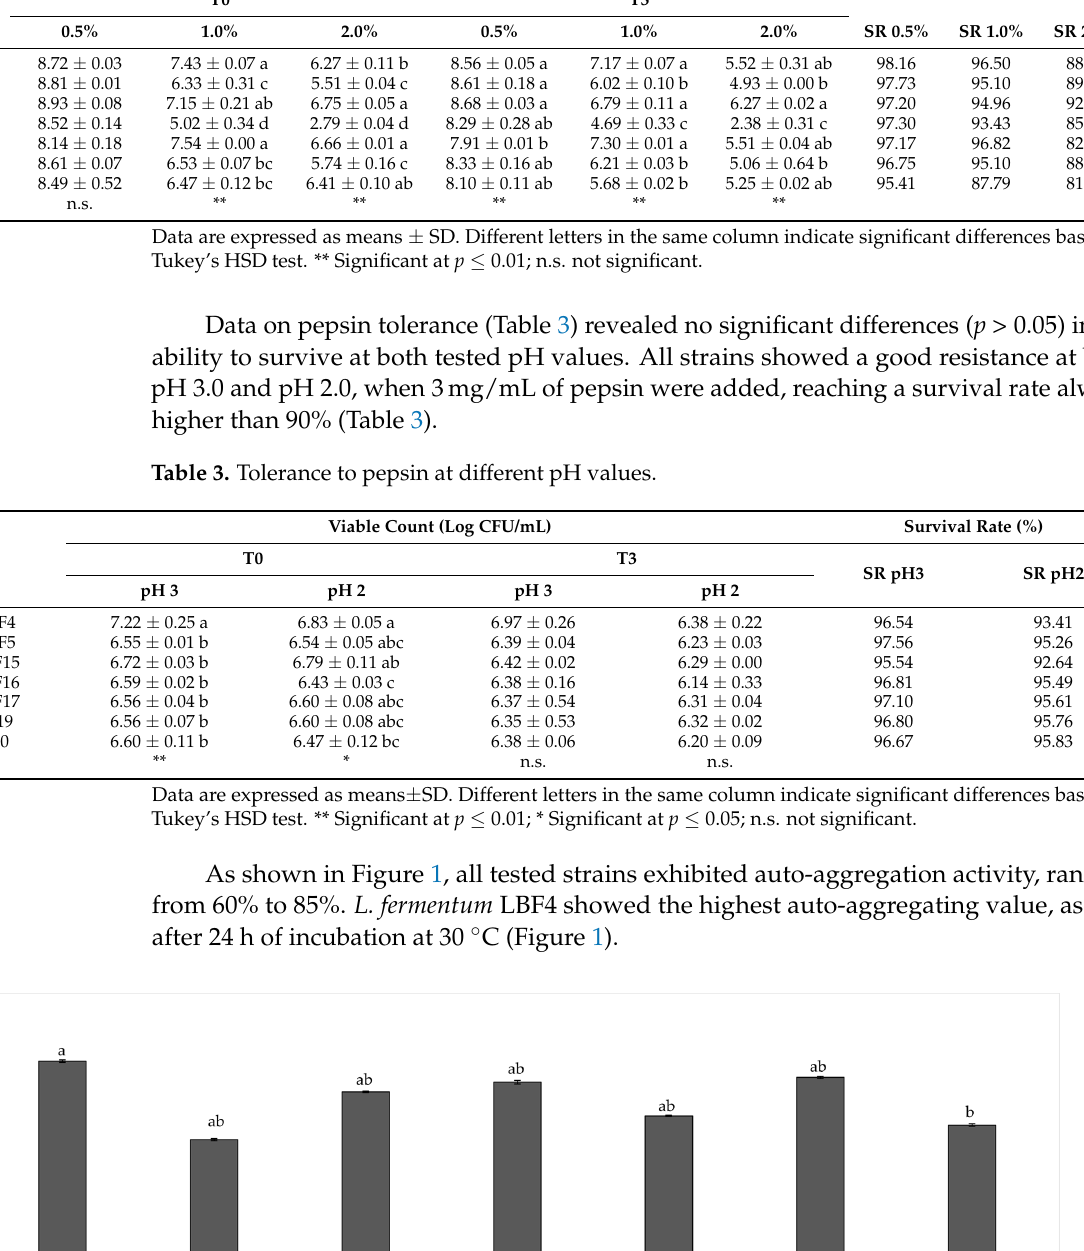
Table 4. Antibiotic susceptibility of LAB strains. Strains